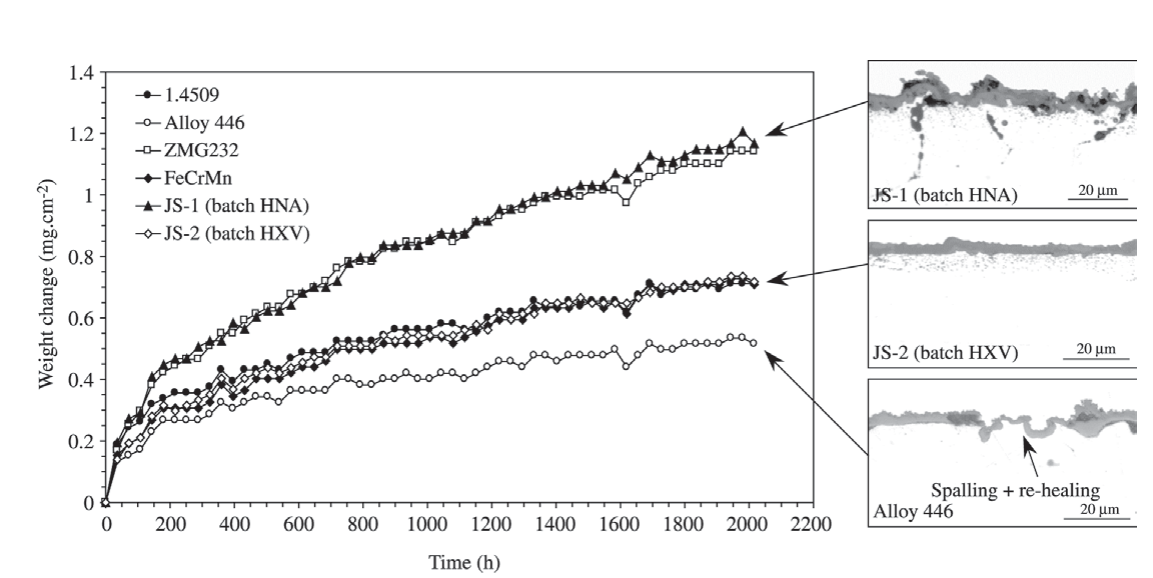
Figure 1. Oxidation behaviour under cyclic conditions of several commercial and model ferritic steels at 800 °C in air.